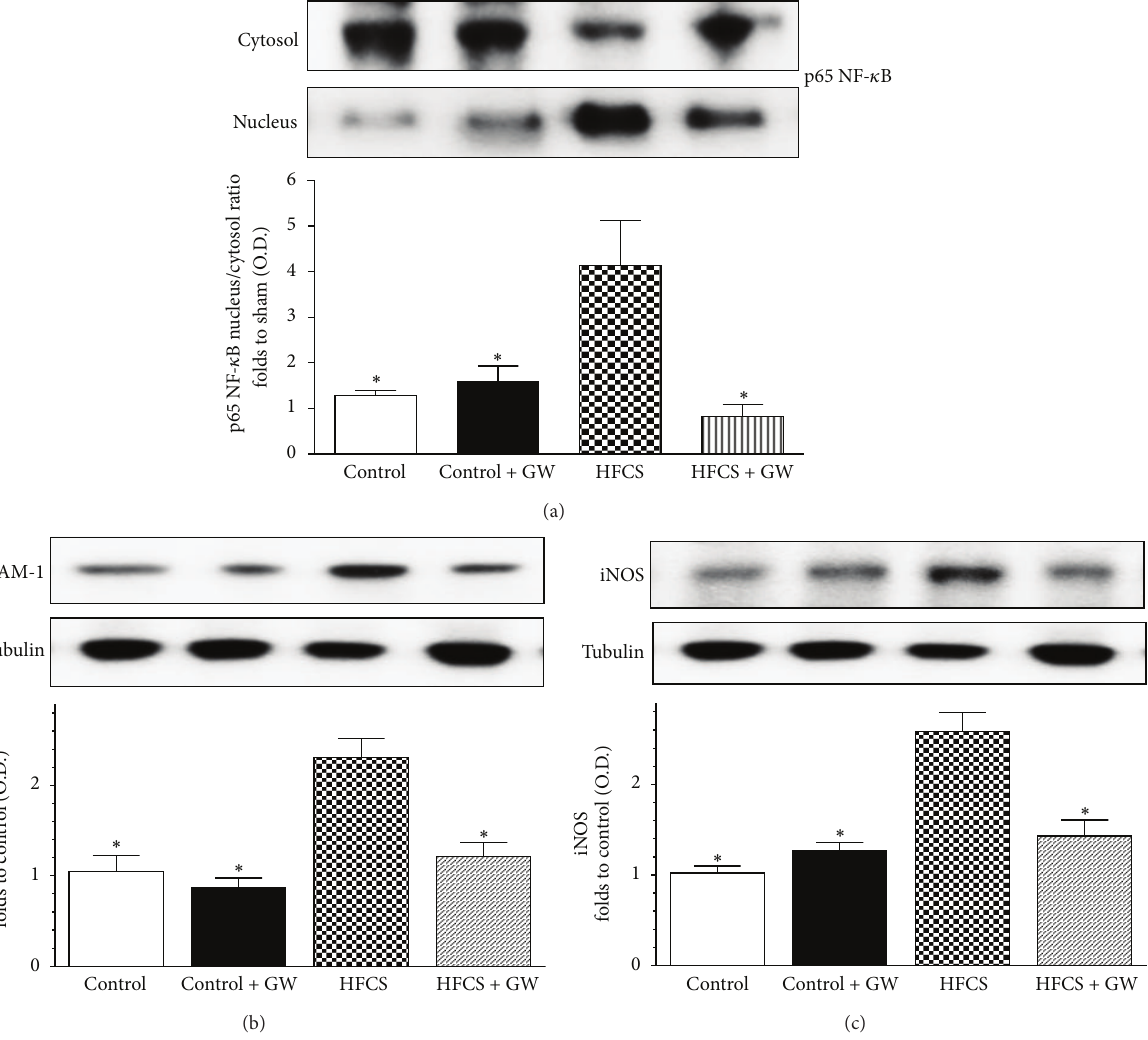
Figure 6: Effects of dietary manipulation and GW0742 treatment on NF- 𝜅 B p65 translocation (a), ICAM-1 (b) and iNOS (c) protein expression in the mouse gastrocnemius. Protein expression was measured by Western blot analysis in gastrocnemius homogenates of mice fed with a standard (control) or HFCS diet (HFCS) in the absence or presence of GW0742 treatment (1mg/kg/day) (control + GW; HFCS + GW). Densitometric analysis of the bands is expressed as relative optical density (O.D.), corrected for the corresponding tubulin contents, and normalized using the related control band. NF- 𝜅 B p65 subunit levels in cytosolic and nuclear fractions are expressed as nucleus/cytosol ratio normalized using the related control band. Data are means ± SD of three separate experiments. ∗ 𝑃 < 0.01 versus